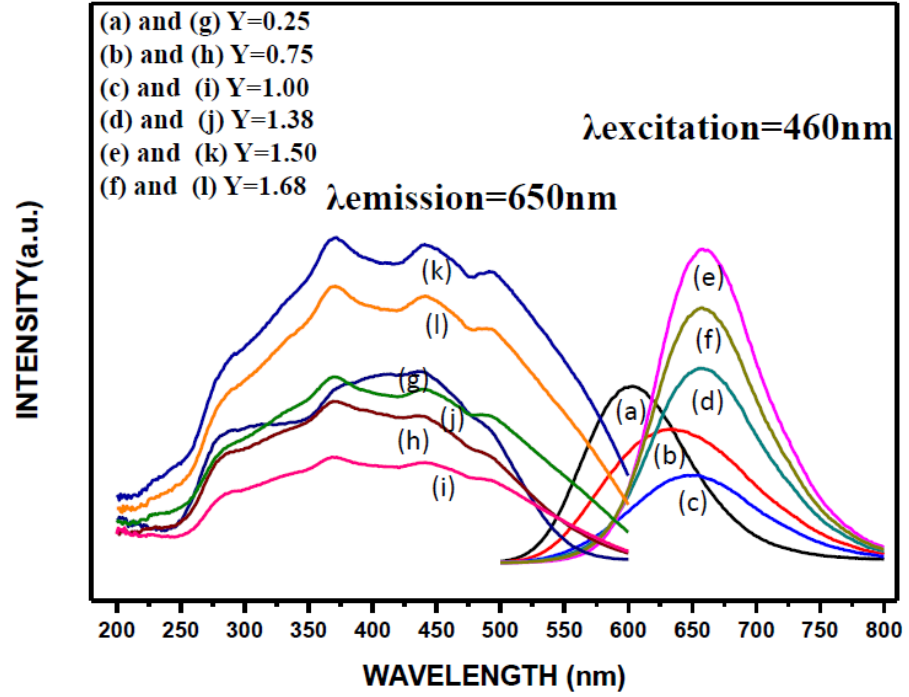
Figure 10. The emission (( a ); ( b ); ( c ); ( d ); ( e ); and ( f ), excited by λ = 460 nm) and excitation (( g ); ( h ); ( i ); ( j ); ( k ); and ( l )) spectra of the phosphors synthesized with various Ca contents.